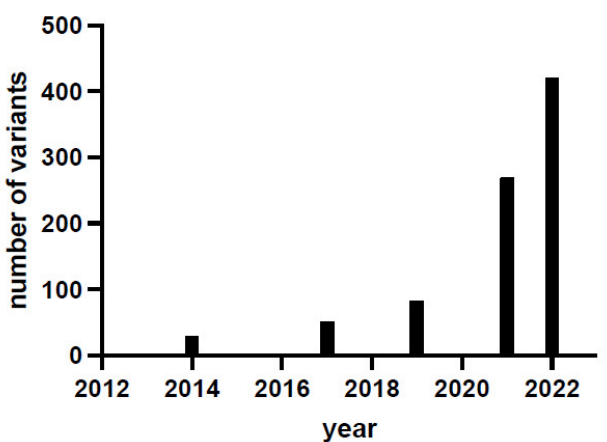
Figure 1. AADC deficiency variant identification in the last decade. Data are taken from [2,3,14] and and from the locus-specific database PNDdb from the locus-specific database PNDdb (http://www.biopku.org/pnddb/search-results.asp ac- cessed on 30August 2022) at the end of December 2021 and of August 2022.